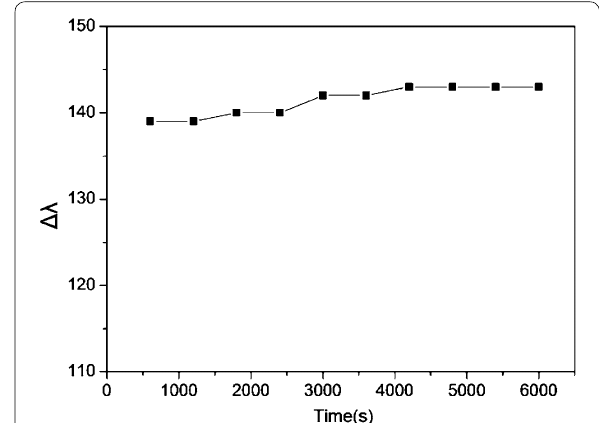
Fig. 5 Effect of reaction time on the peak shift of the AuNR@Ag sensing system with adding 10 μM Cr(VI)